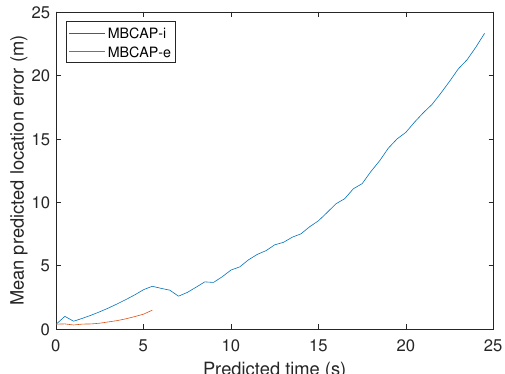
Figure 8. MBCAP-i vs. MBCAP-e: Average predicted location error for each of the predicted positions on the